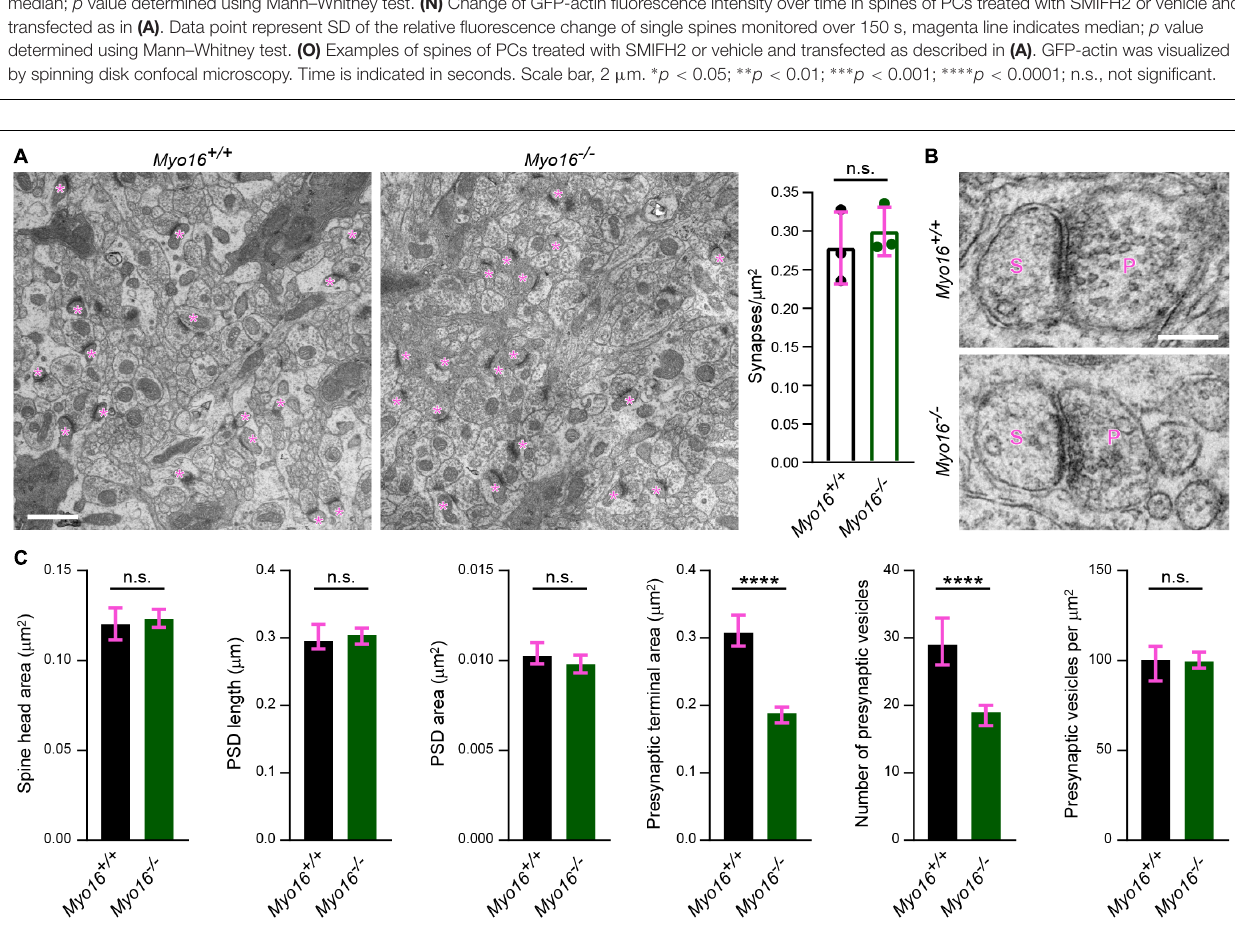
FIGURE 8 | Ultrastructural analysis reveals altered presynaptic organization in the cerebellar molecular layer of Myo16 − / − knockout mice. (A) Electron microscopy images of the middle one third of the cerebellar molecular layer of adult male Myo16 em 3 knockout ( Myo16 − / − ) and Myo16 + / + littermate control mice were surveyed for asymmetric synapses (indicated by magenta asterisks). Graph shows number of synapses per µ m 2 ; bars indicate mean ± SEM (magenta), n = 3 (single data points represent mice analyzed), no significant differences detected (n.s.; p value determined using Student’s t -test). Scale bar, 1 µ m. (B) Representative electron microscopy images of cerebellar molecular layer synapses of adult male Myo16 em 3 knockout ( Myo16 − / − ) and Myo16 + / + littermate mice. S, spine; P, presynaptic bouton. Scale bar, 250 nm. (C) Quantitative analysis of morphological parameters of cerebellar molecular layer synapses of Myo16 − / − and Myo16 + / + mice. Data are shown as median ± 95% confidence interval (magenta), n = 236 synapses ( Myo16 + / + ) and 380 ( Myo16 − / − ); p values determined using Mann–Whitney tests. ∗ p < 0.05; ∗∗ p < 0.01; ∗∗∗ p < 0.001; ∗∗∗∗ p < 0.0001; n.s., not significant.